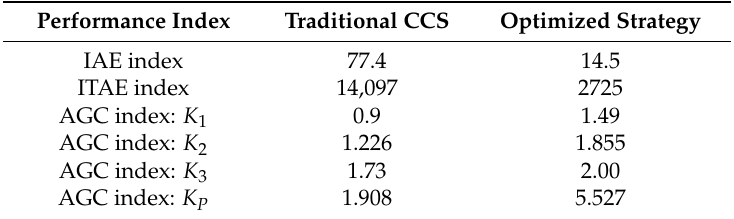
Table 3. Control performance index with two different strategies.